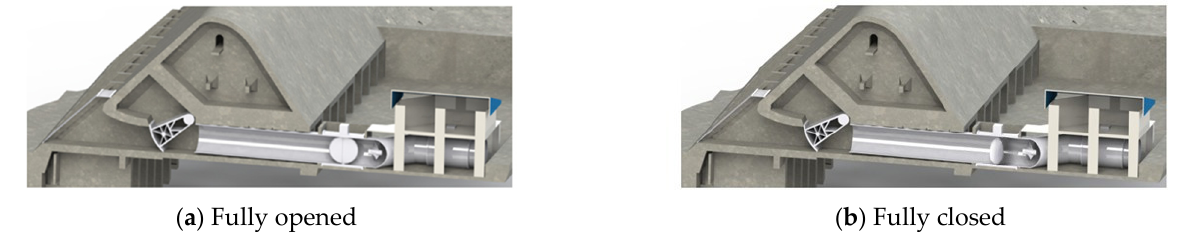
Figure 9. Condition of butterfly valve when fully opened and fully closed.